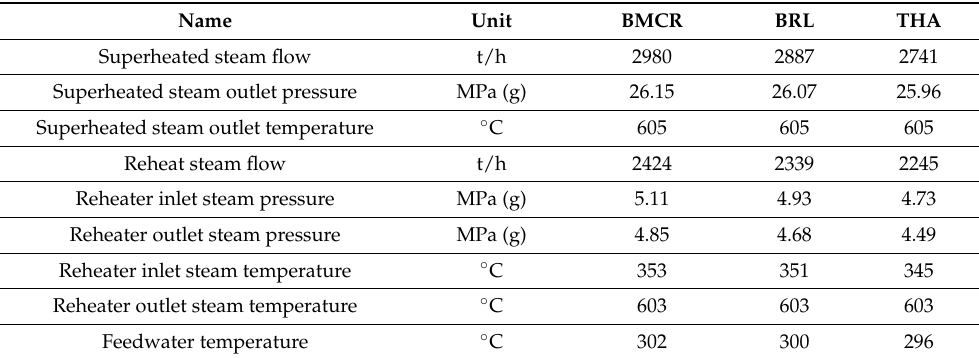
Figure 2. Schematic of boiler structure. Table 1. Main design parameters of boiler.